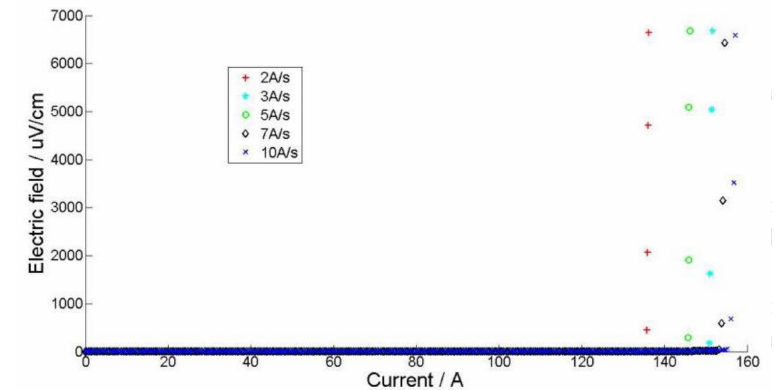
Figure 7. SuperOX tape with different ramp